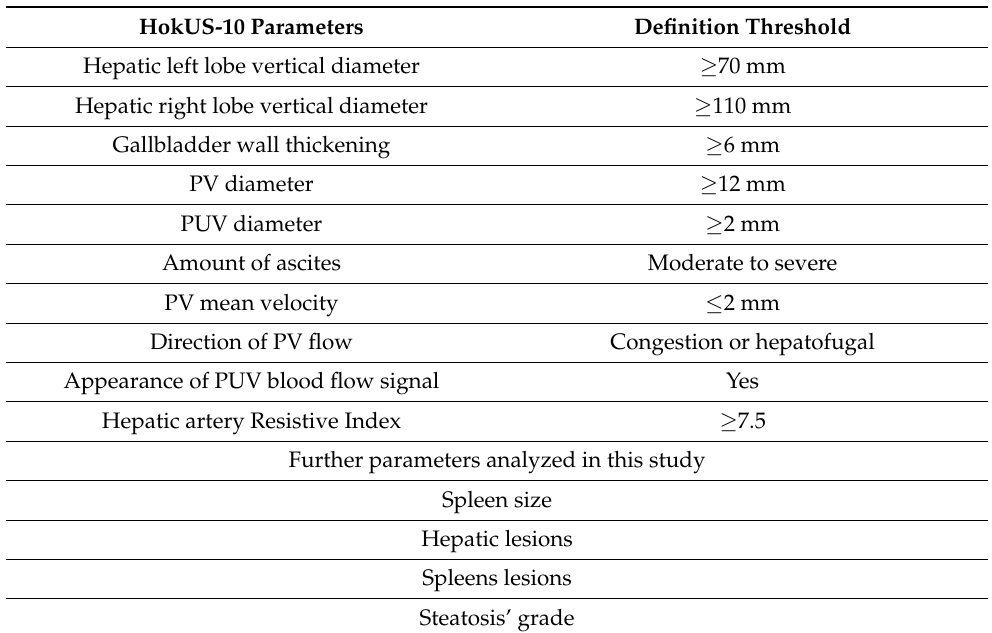
Table 1. List of the Parameters required by HokUS-10 US score system to diagnose SOS/VOD and additional parameters analyzed.